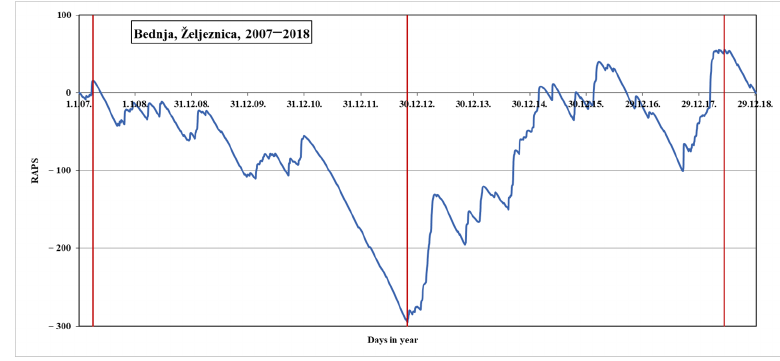
Figure 12. RAPS value on flow data from Lepoglava measurement station.